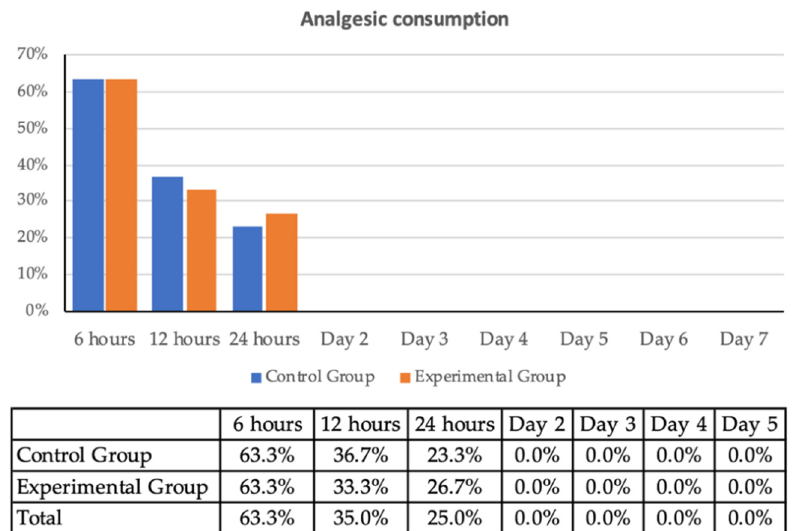
Figure 3. Mean values of pain intensity recorded by VAS.